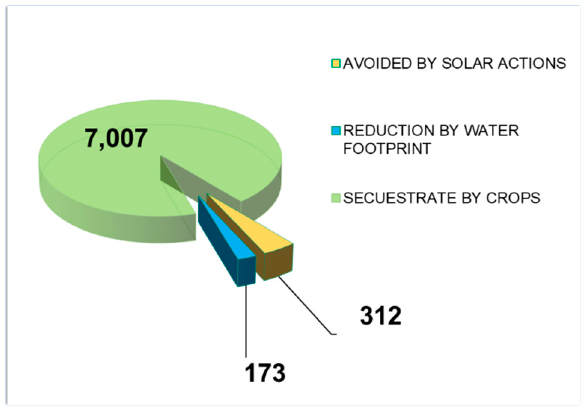
Figure 12. Summary new future reduction t CO 2 eq/y after actions. Source: Own elaboration.